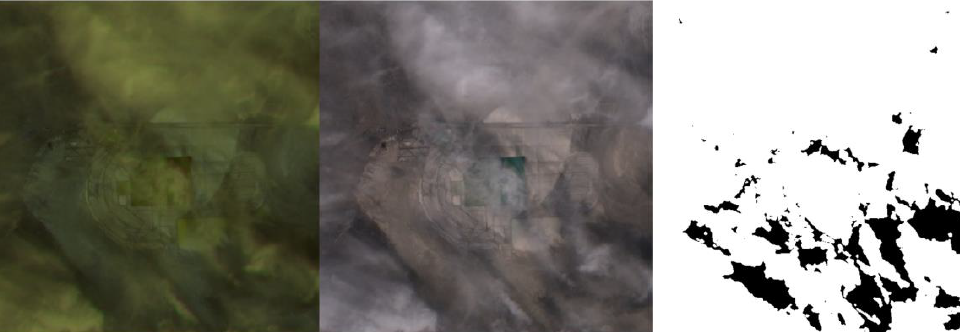
Figure 8. Aral sea clouds and ice; radiance image, RGB image, cloud mask. False Positive case.